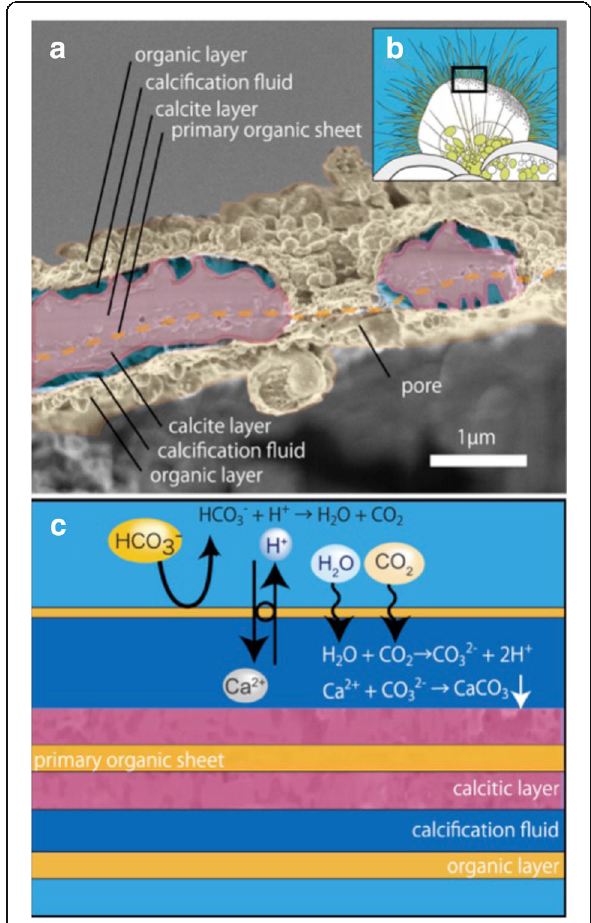
calcification at the enclosed site of calcification (SOC). a Magnified SEM image of the cross section of SOC. Upper side is the outer side, whereas the lower side is the cellular side. b Black rectangle indicates the observed newly calcifying chamber in ( a ). c Considerable calcification model based on Toyofuku et al. (2017) and Nagai et al. (2018). During chamber formation on an organic template (termed the primary organic sheet, POS), the organic layers isolate the growing calcite surface from the surrounding seawater. The chemical composition of the calcification fluid of the SOC is characterized by active, outward proton pumping coupled with an inward calcium ion-flux. The transported proton reduced pH around the foraminiferal microenvironment. Inorganic carbon speciation is shifted by this lower pH, thereby increasing p CO 2 of the surrounding seawater near the site of calcification. The large gradient in p CO 2 around the individual results in the diffusion of CO 2 into the site of calcification. This inbounded CO 2 reacts to form carbonate ions due to the high pH at the site of calcification. This transported carbon source sustains CaCO 3 precipitation by reacting with the inward- transported calcium